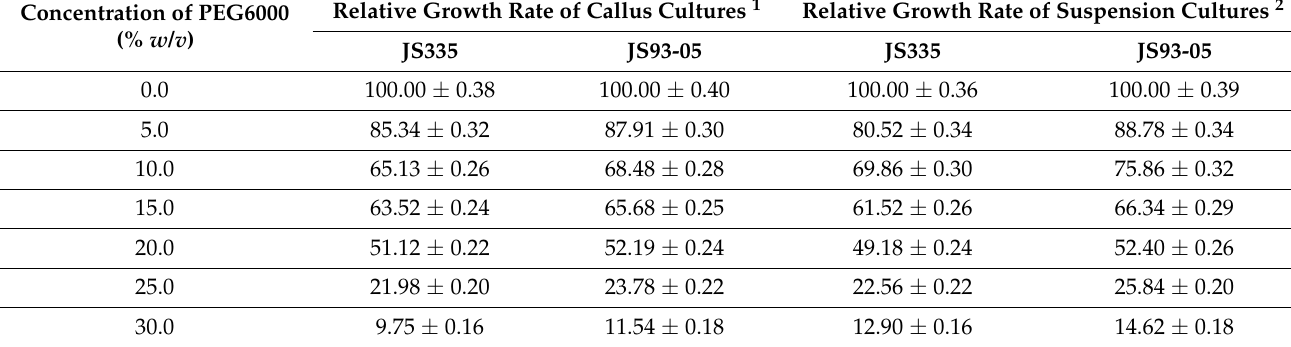
Table 3. Comparison of growth rates 1 of mature and immature embryonic axis and cotyledons derived calli and embryo- genic cell suspension cultures on different levels of